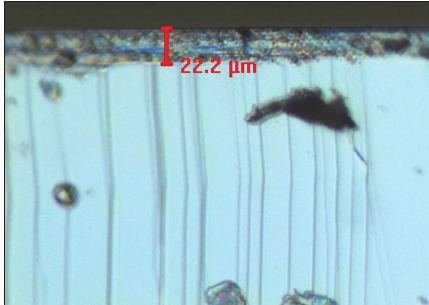
Figure 2: Optical micrograph of the lateral cut of the film prepared with an irradiation time of 5min (40x magnification).